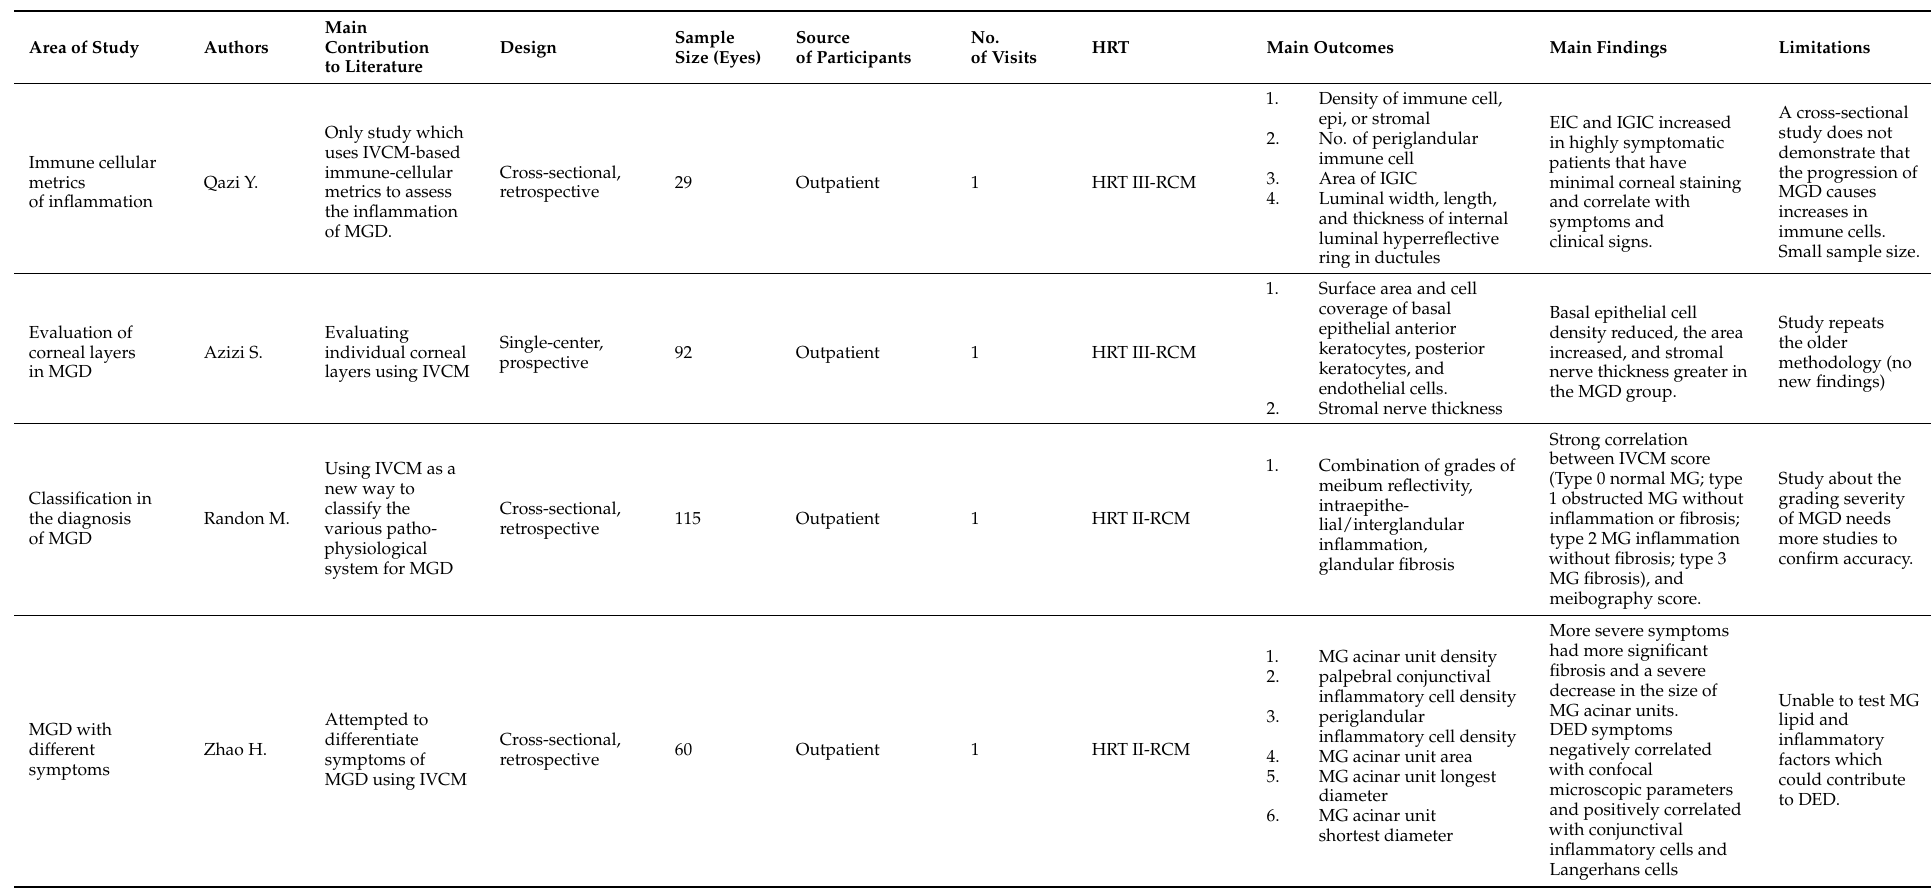
Table 1. Studies on Meibomian Gland Dysfunction